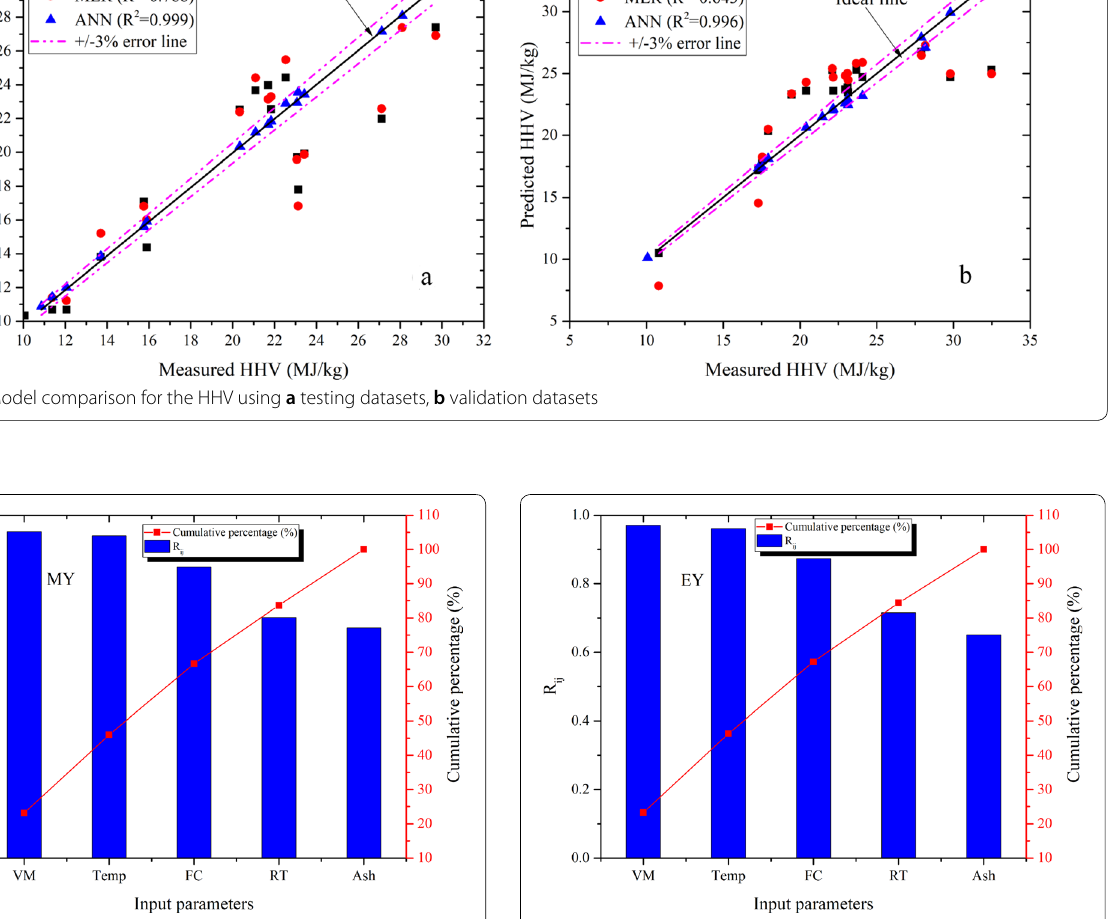
Fig. 12 Input parameters contributions to the predicted EY Fig. 11 Input parameters contributions to the predicted